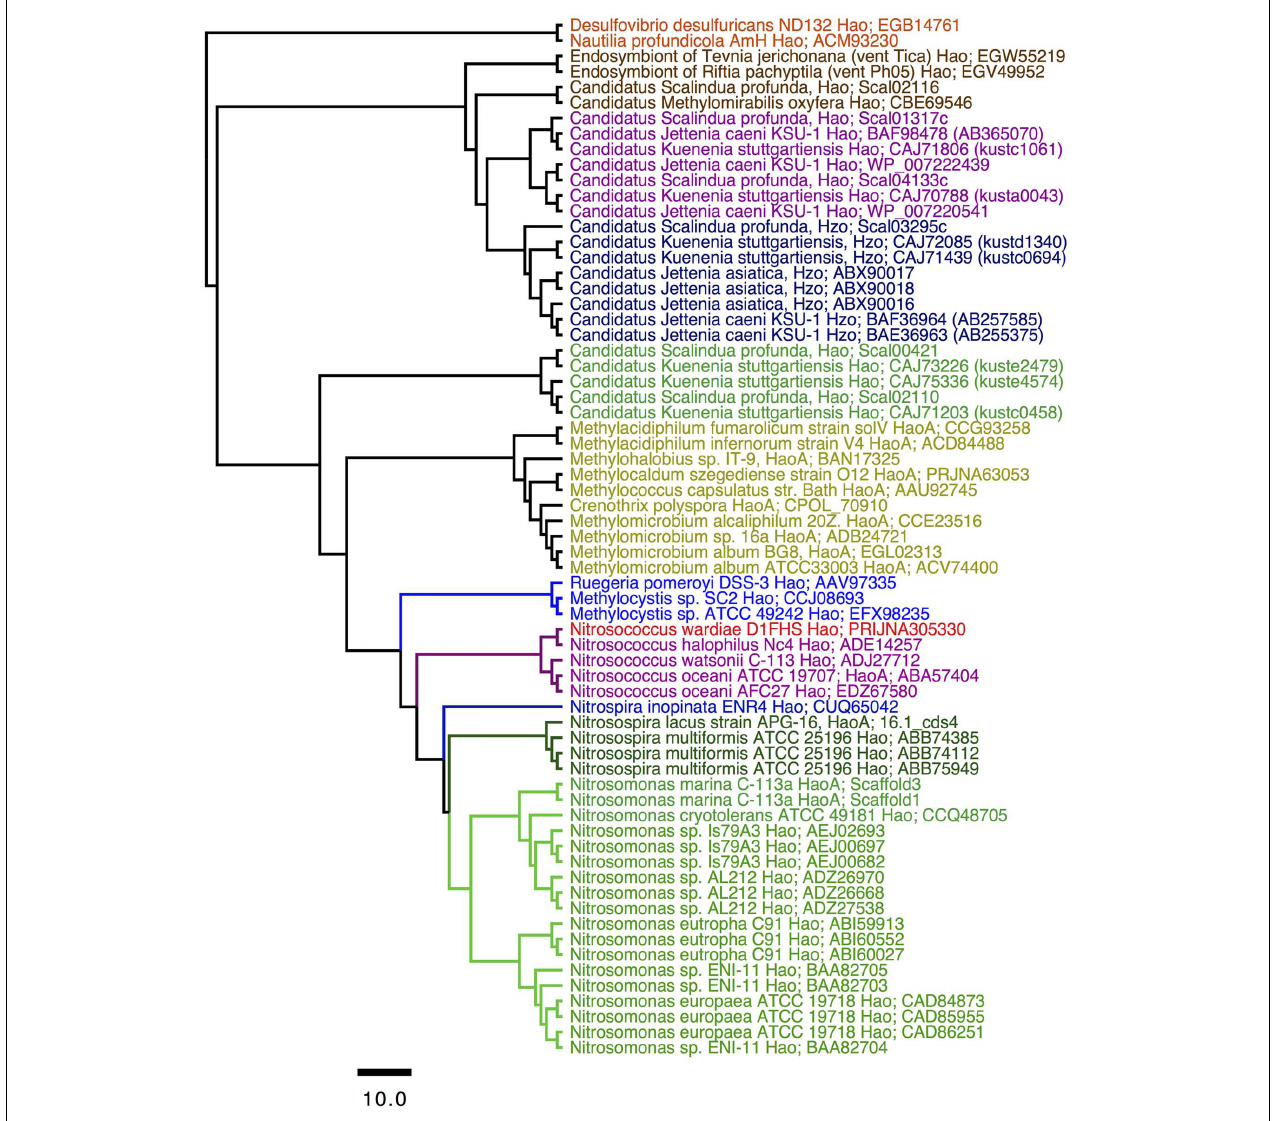
FIGURE 2 | Consensus tree constructed after Bayesian inference of phylogeny from the MUSCLE alignments of sequences from octaheme cytochrome c proteins in the “Hao cluster” (Klotz et al., 2008; Kern et al., 2011) using the sequence from “reverse Hao” proteins as the out group (Hanson et al., 2013). The N- and C-terminal sequences outside the heme c binding motifs were eliminated from the final alignment that was subjected to Bayesian inference of phylogeny using the BEAST package (see Experimental procedures ). Posterior probability values of all nodes were ≥ 0.99. Mean branch lengths are characterized by a scale bar indicating the evolutionary distance between the proteins (changes per amino acid position). The branches are annotated with labels indicating the source organism and the protein sequence accession